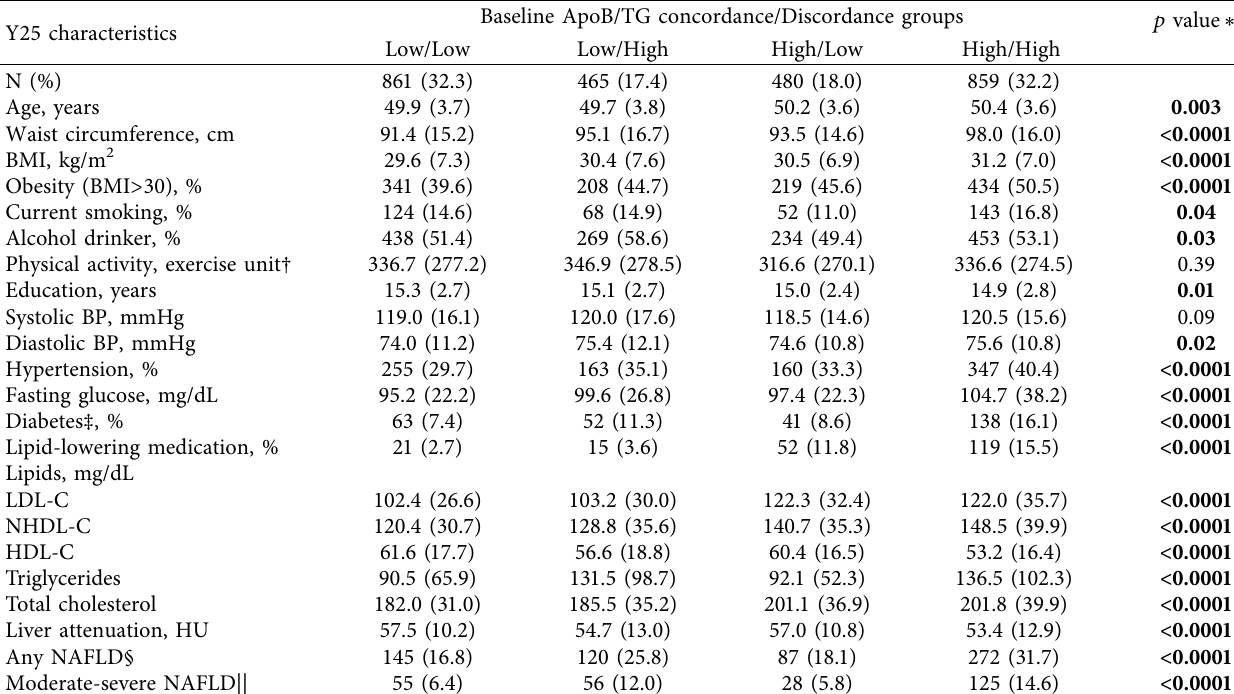
Table 3: Y25 characteristics of NAFLD-eligible participants by concordance/discordance groups Based on medians of ApoB/TG levels [the CARDIA study (2010–2011)].